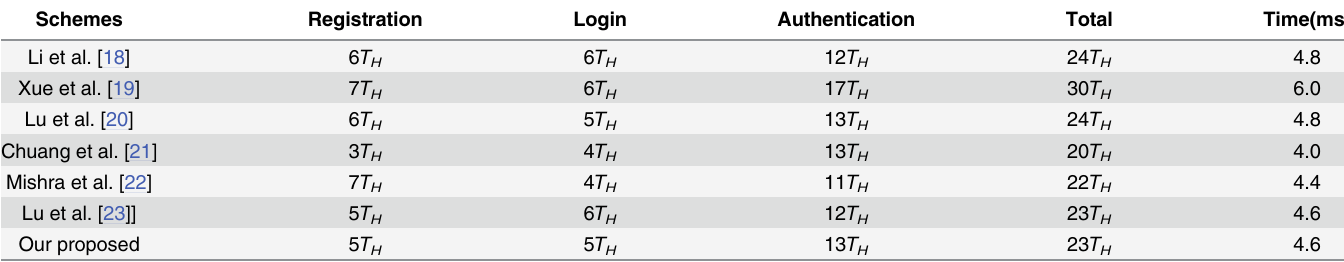
Table 6. Computational costs